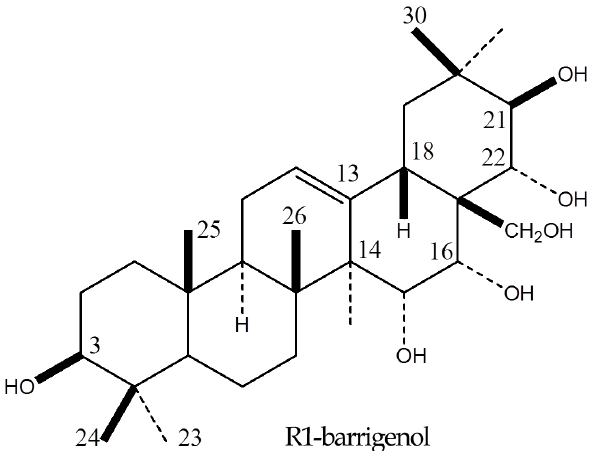
Figure 1. Structure of the active compound from P.